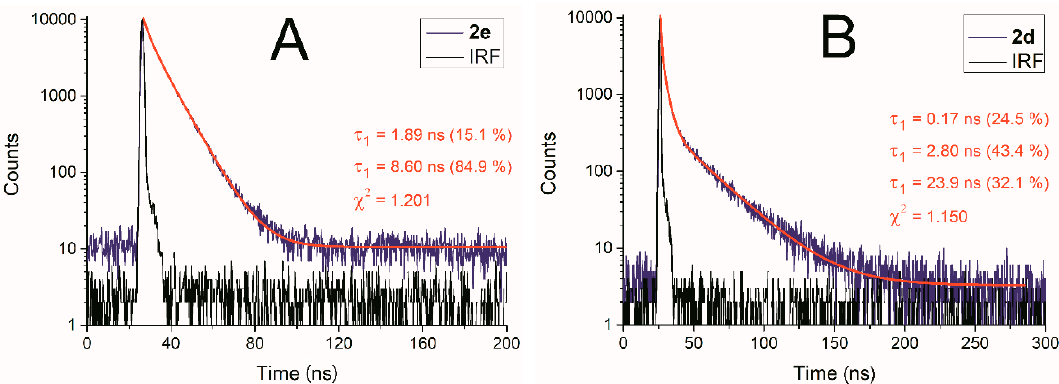
Figure 5. Fluorescence decay profiles of the carbolines 2e ( A ) and 2d ( B )in thin solid films obtained using an excitation wavelength of 340 nm and 402.8 nm, respectively (monitored at emission maximum; IRF, instrument response function).